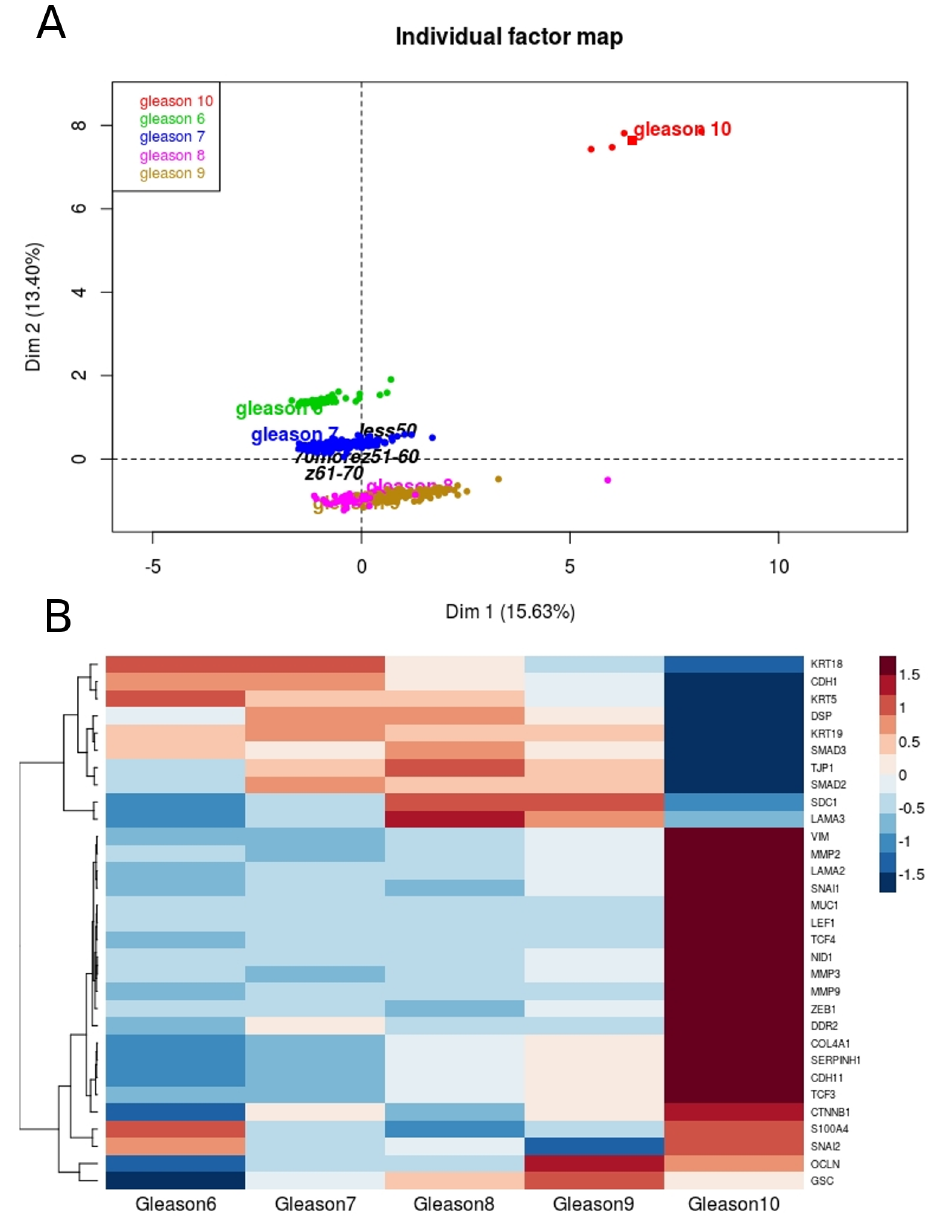
Fig 5. Expression of EMT markers differentiates well Gleason score. A) Combinedexpressionof selectedEMT markers partitions Gleason score along the PCA dimensions. B) Expression of particularEMT markers changeswith Gleason